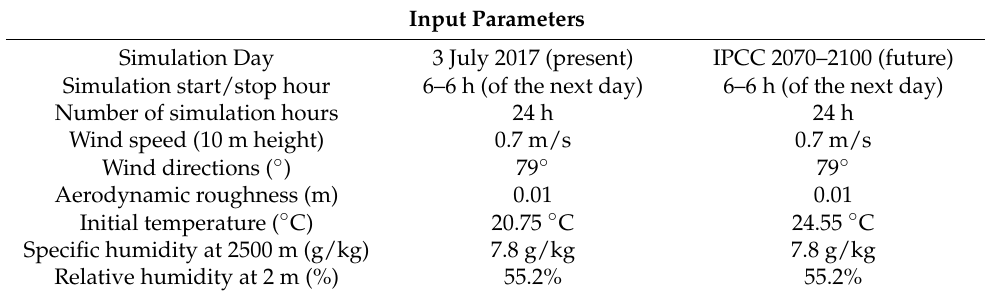
Table 3. Input parameters to the 3D simulations for the present and future